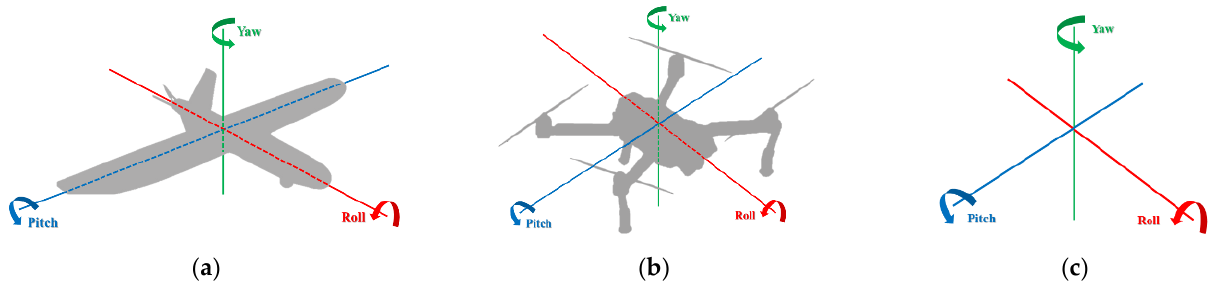
Figure 3. Identification of the three axes and three rotations on a fixed-wing UAV ( a ), on a quadcopter ( b ), and schematisation of axes and rotations ( c ).